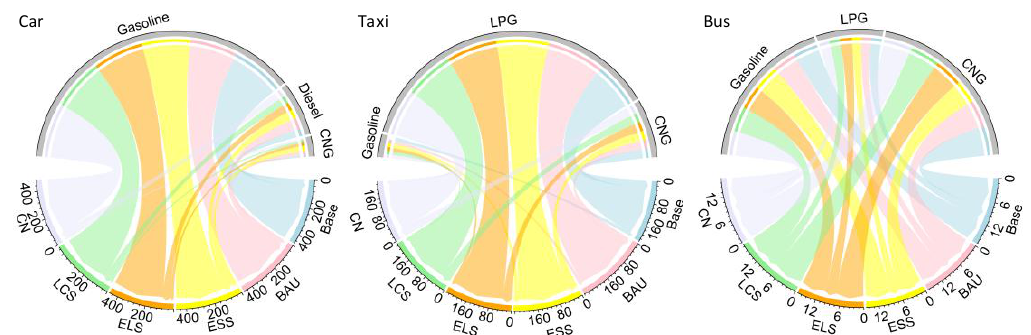
Figure 5. CO 2 emissions of different traffic ways in base year and peak time (BAU, ESS, ELS, LCS, CN) in transportation sector of Jilin (unit: TMt). For example, in the chord diagram (left), carbon emissions of cars in the CN scenario are 404.92 tons from gasoline consumption, 57.74 tons from diesel consumption and 14.42 tons from CNG consumption in peak time.